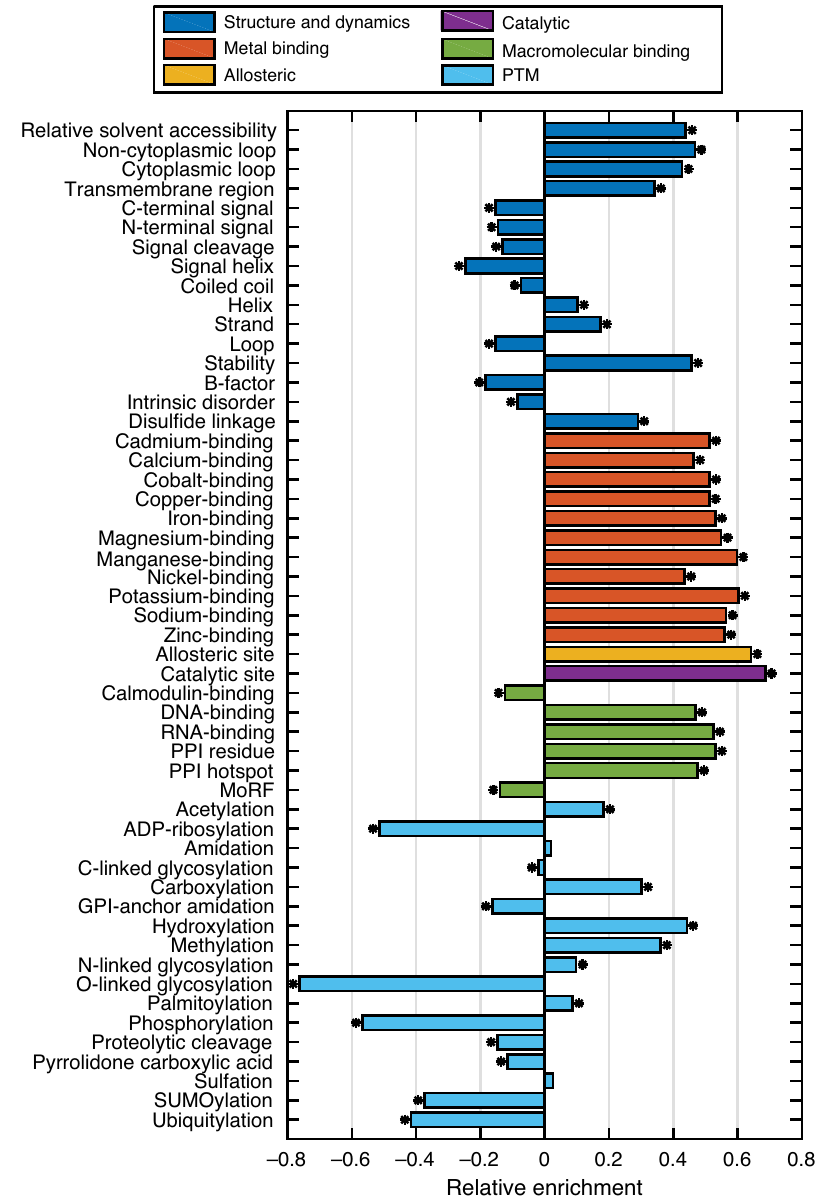
Fig. 3 Signi fi cantly enriched and depleted pathogenic mechanisms predicted by MutPred2. The data set consisted of 53,180 inherited disease mutations and an unlabeled set of 205,303 variants. Losses and gains are plotted together by considering the maximal effect for a given mutation position. An asterisk indicates signi fi cance at the 0.05 level with Benjamini – Hochberg correction, as computed by a one-sided Fisher ’ s exact